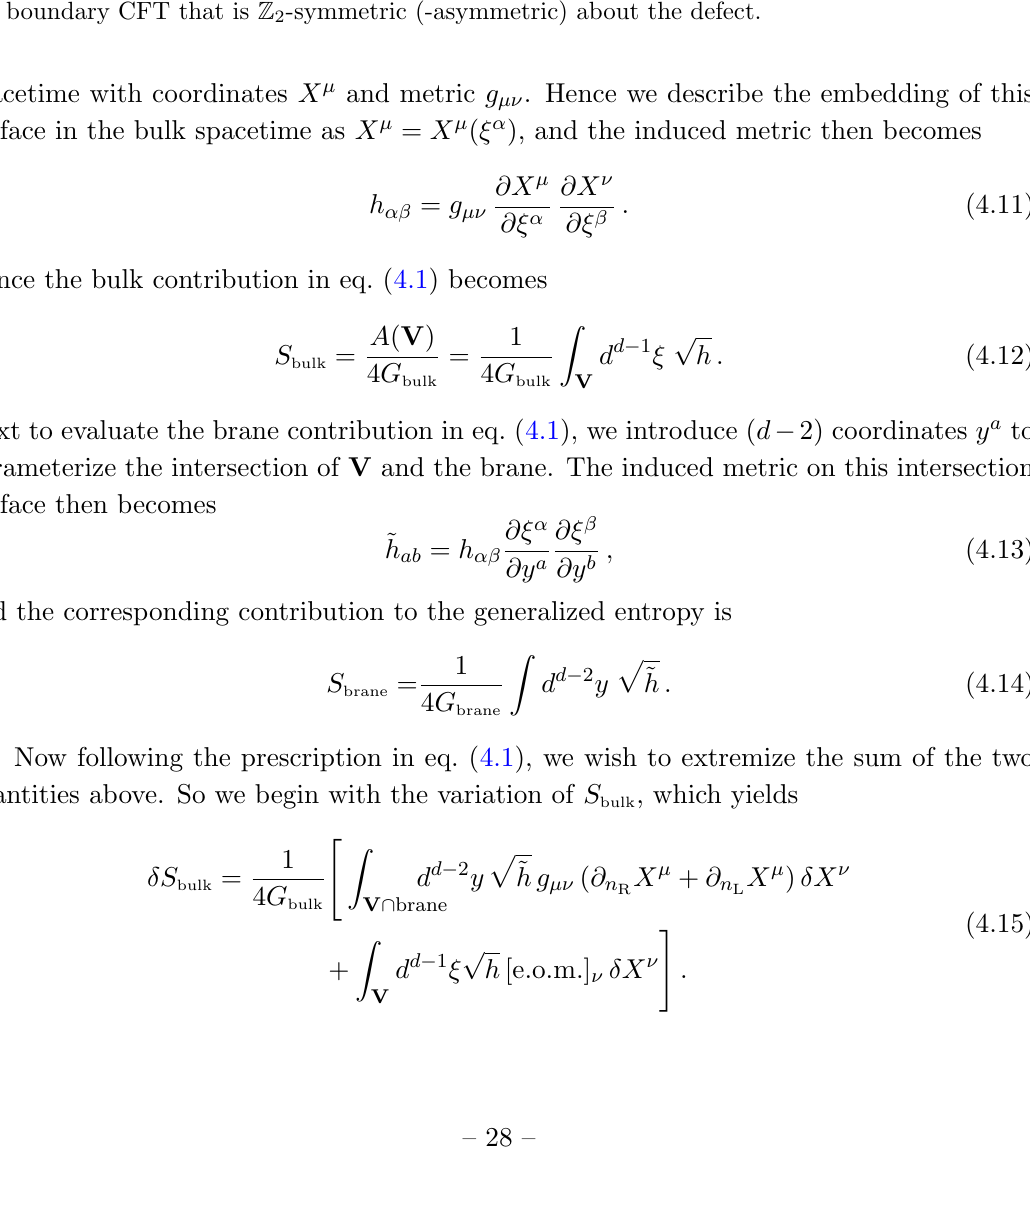
Figure 6 . Families of extremal surfaces anchored at (cid:12)xed positions on the asymptotic AdS bound- ary. The true RT surfaces are the members of these families which extremize area in the bulk, or equivalently, generalized entropy in the brane perspective. The RT surfaces in the case of zero, positive, and negative 1 =G are respectively shown in solid, dashed, and dotted red. In the brane absence of a DGP Einstein-Hilbert action (1 =G = 0), the RT surfaces passe ‘straight’ through brane the brane. The left (right) panel shows the computation of entanglement entropy for a region in the boundary CFT that is Z 2 -symmetric (-asymmetric) about the